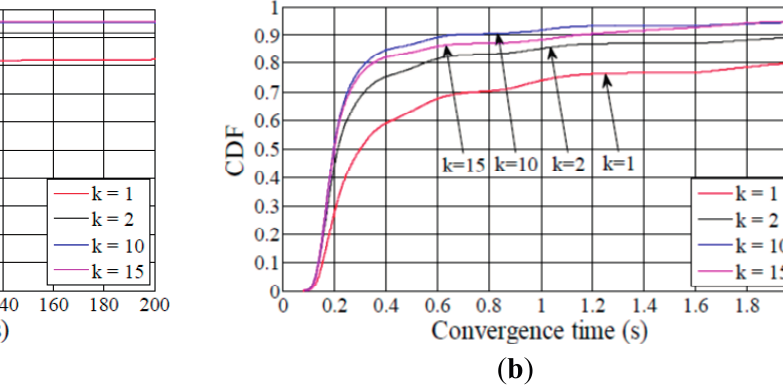
Figure 6. CDF of network convergence time in the medium network size scenario. The average node degrees are 5, 10 and 15 in figures ( a ), ( b ) and ( c ),